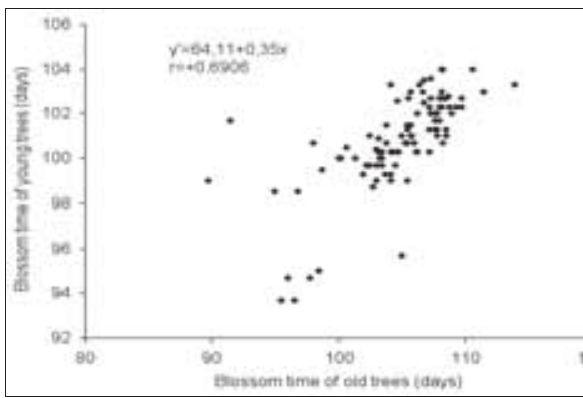
Figure 1. Blossom time relationship between cultivars and age of trees